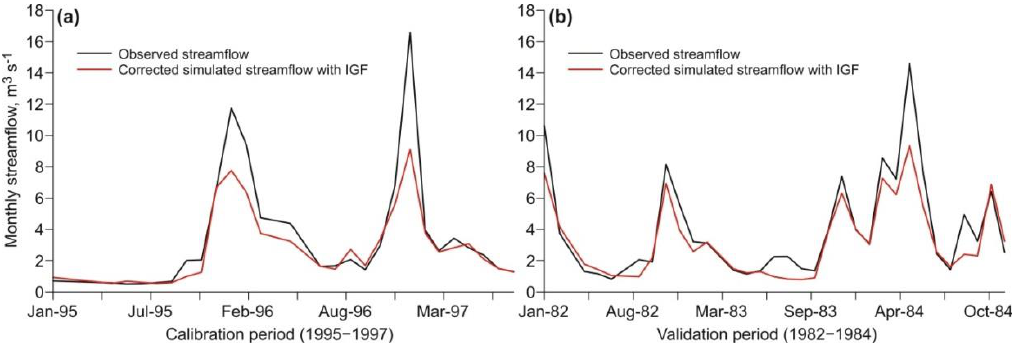
Figure 7. On a monthly scale, observed streamflow compared to corrected simulated streamflow with SWAT model for the ( a ) calibration and ( b ) validation phases.